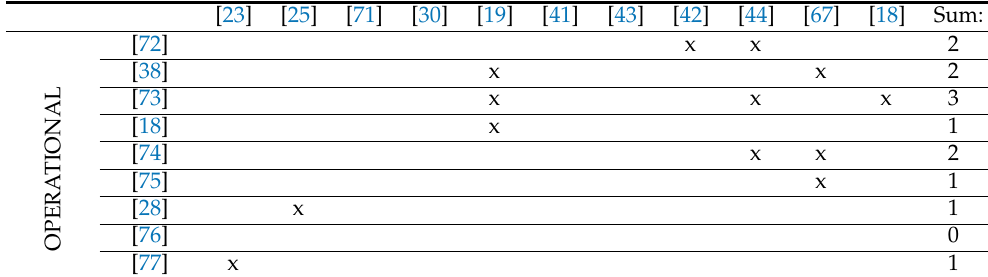
Table 1. Classification of radar sensor model approaches and relation to previous